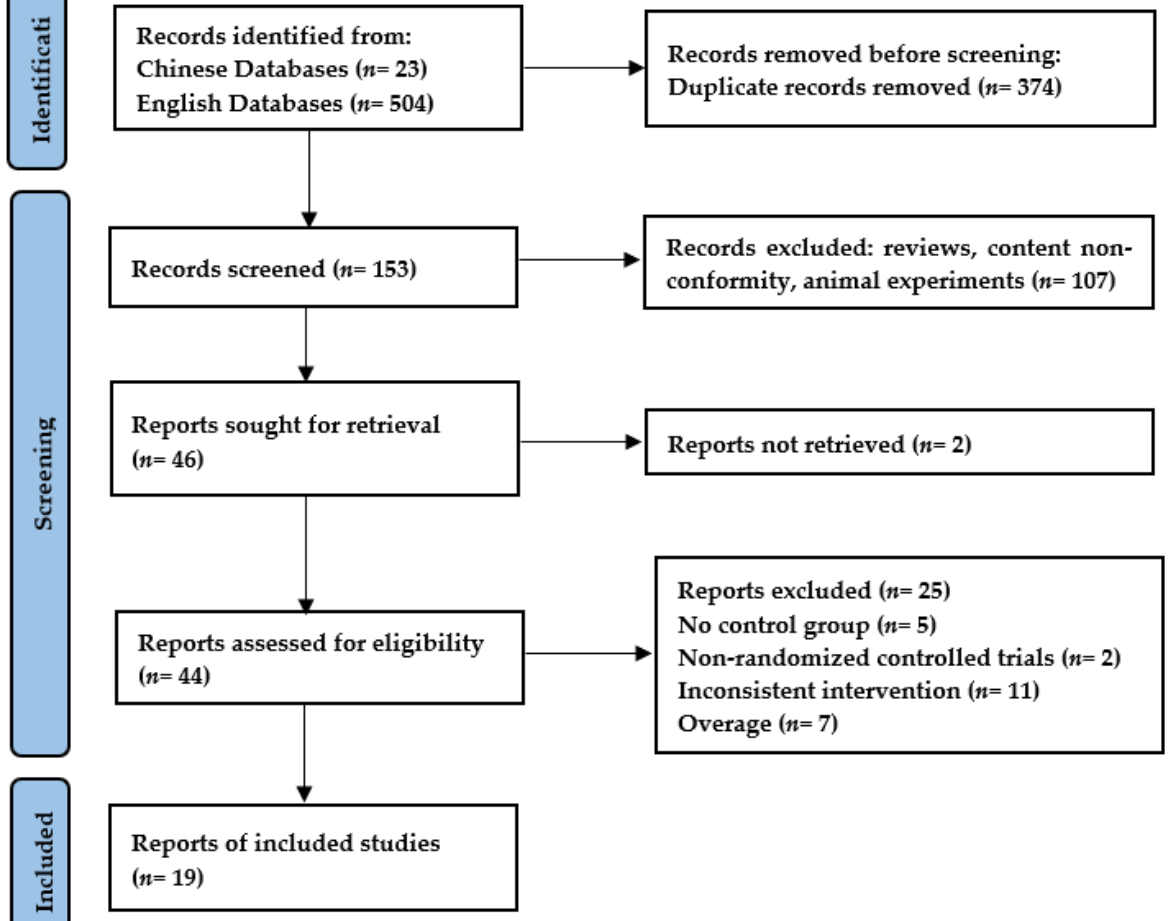
Figure 2. PRISMA flow chart for inclusion and exclusion of studies.